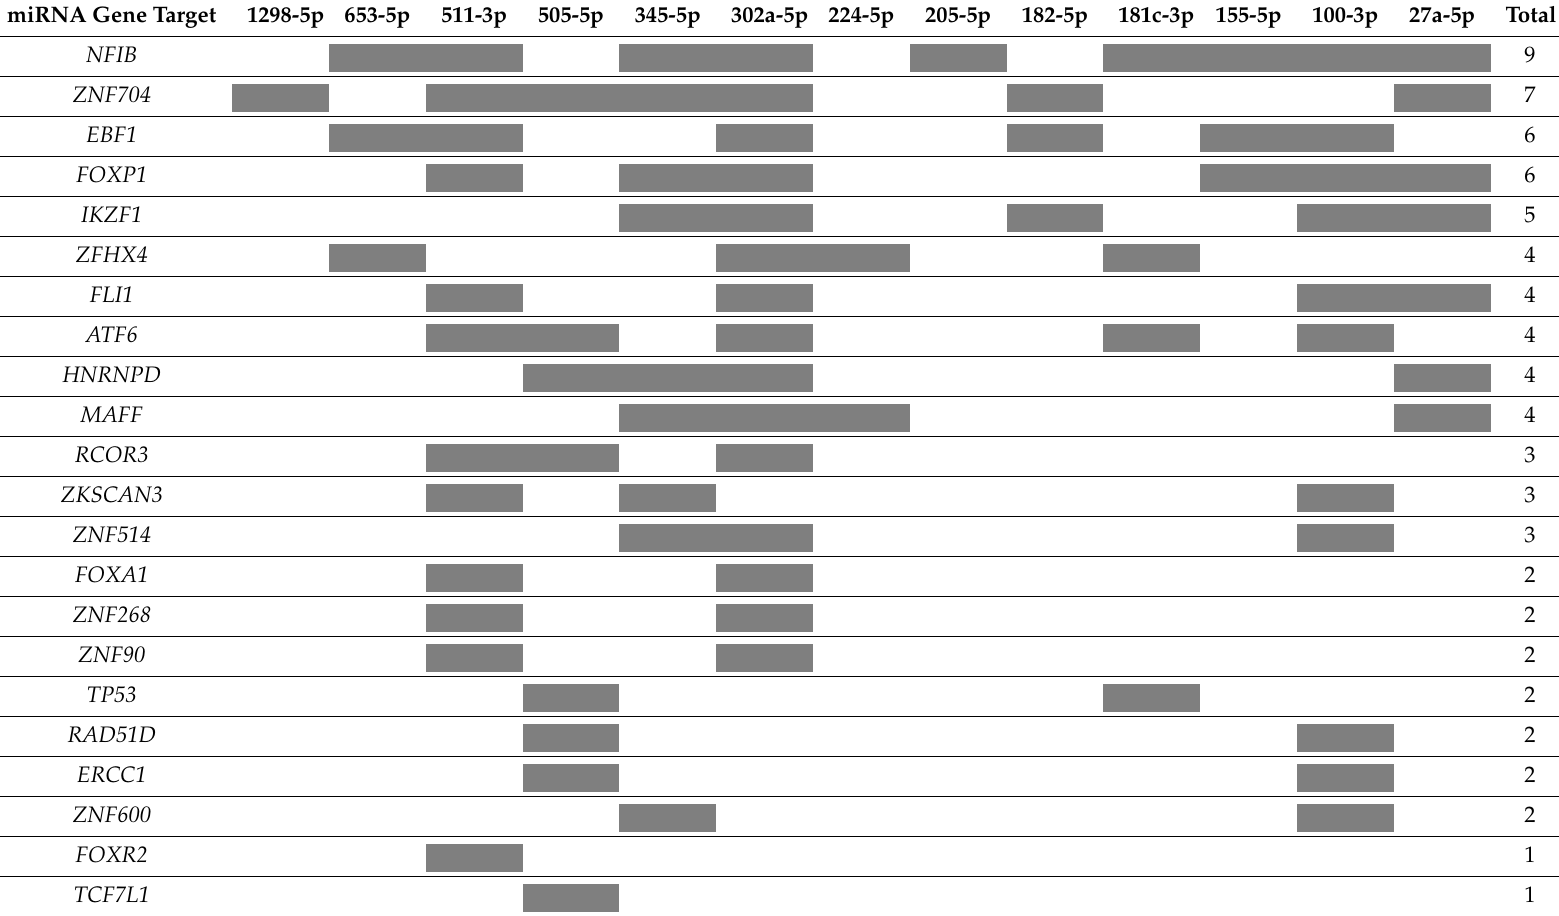
Table 2. miRNAs which target genes relating to DNA binding. The shaded box indicates that a gene is present in the list of targets of the miRNA. This comparison has a highly significant p -value of 1 × 10 − 12 . All but two of the genes present in the list are targets of more than one